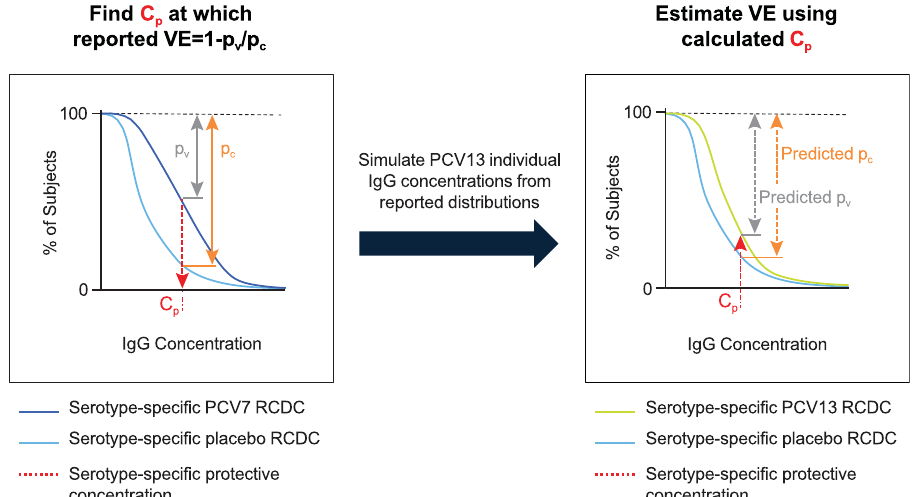
Fig. 1 Modeling fl ow chart. The fl ow chart illustrates the two-step method for predicting the vaccine effectiveness (VE) of the PCV7 serotypes in PCV13. Beginning with the known serotype-speci fi c IgG concentrations after vaccination with PCV7 (both placebo and active vaccine), simulated reverse cumulative distribution curves (RCDCs) are used, along with the known serotype-speci fi c VE of PCV7 (where VE ≈ 1- (p v /p c )), (p v is the percentage of subjects with antibody levels less than protective antibody concentration (C p ) in the vaccinated cohort, and p c is the percentage of subjects with antibody levels less than C p in the control cohort) to derive the C p that makes 1-(p v /p c ) agree with reported VE for each serotype in PCV7 (red arrow in the left panel). Then, RCDCs are simulated for the PCV7 serotypes using PCV13 recipients ’ serotype- speci fi c PCV immunogenicity data. The C p values previously derived for these serotypes are used to estimate the VE for those serotypes (see arrows in right